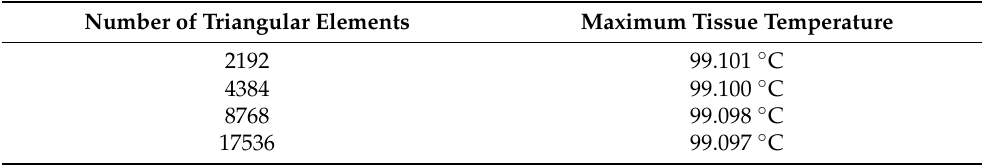
Table 3. Maximum tissue temperatures evaluated for different triangular elements of the mesh.